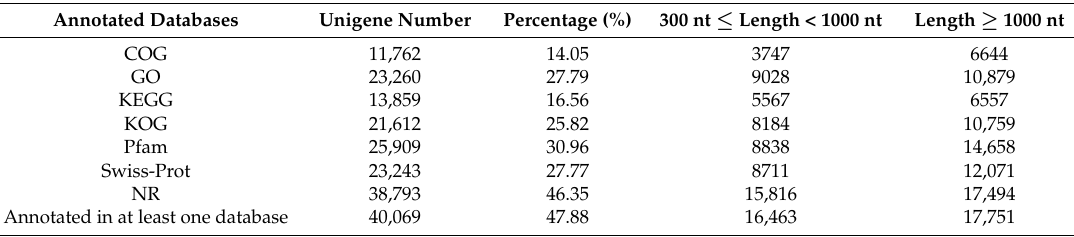
Table 2. Summary for the annotation of